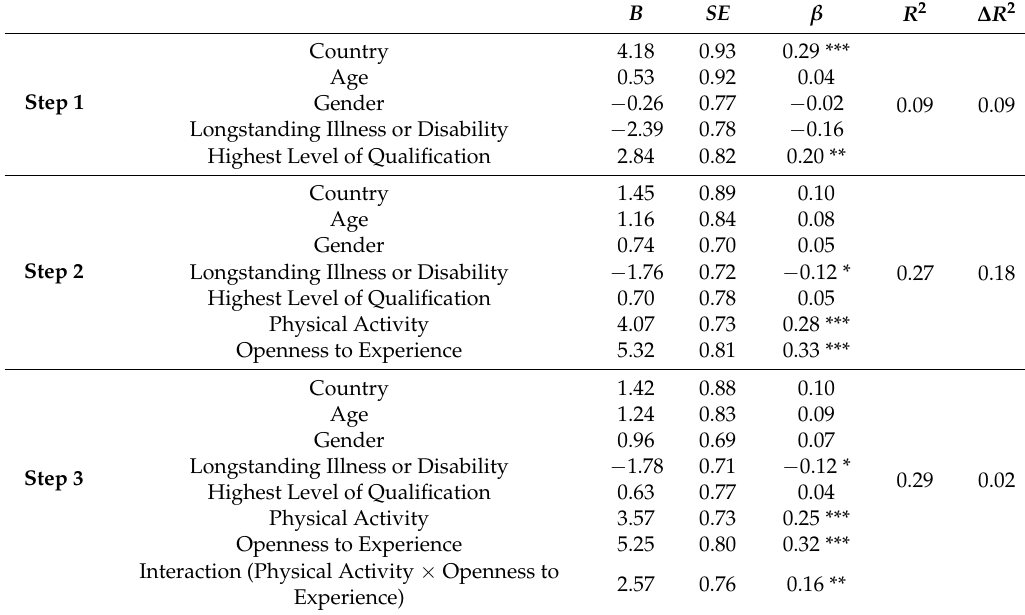
Table 8. Interaction analysis for physical activity and openness to